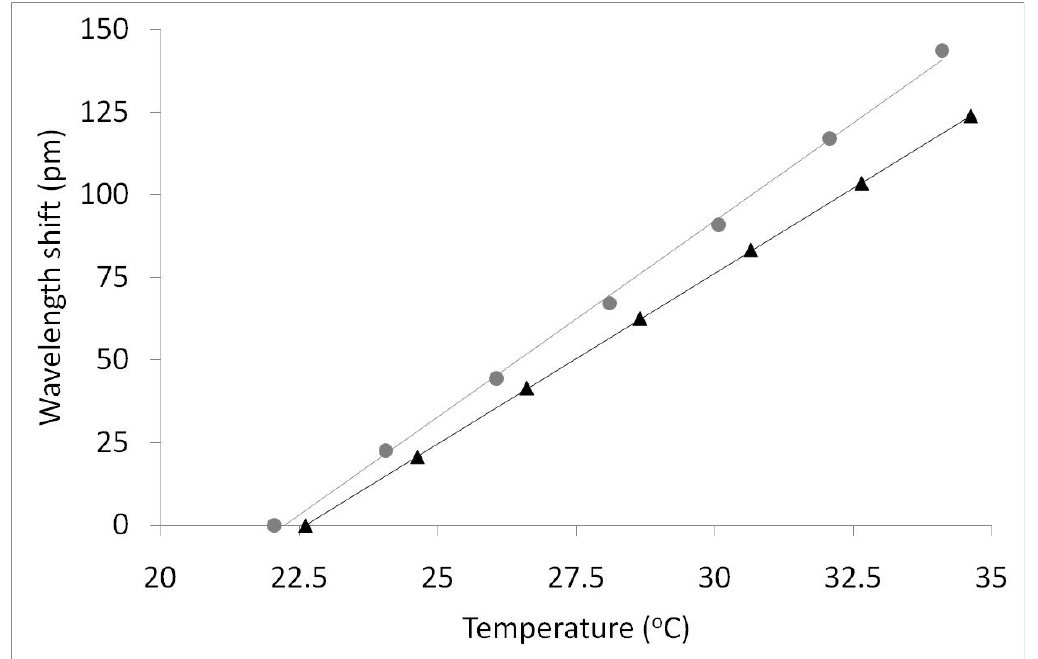
Figure 5. Temperature response for PM FBG in both the Fast and Slow axes of the fiber (10.326 ± 0.02 pm/°C and 11.858 ± 0.2 pm/°C for slow and fast axes respectively). ● (grey), Fast and ▲ (black), Slow